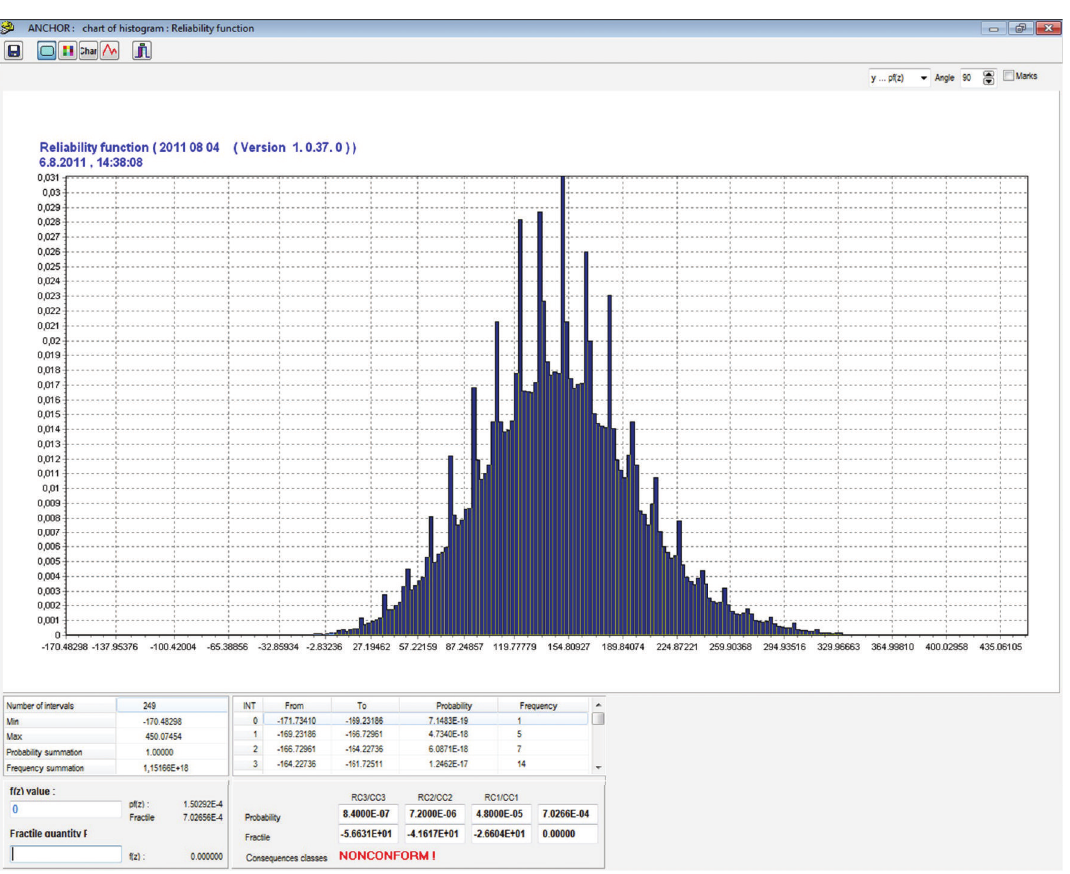
Figure 14: Histogram of the RF reliability function where the failure probability is 𝑃 𝑓 = 7.0266 ⋅ 10 −4 , for 5 bolts per one meter of the underground